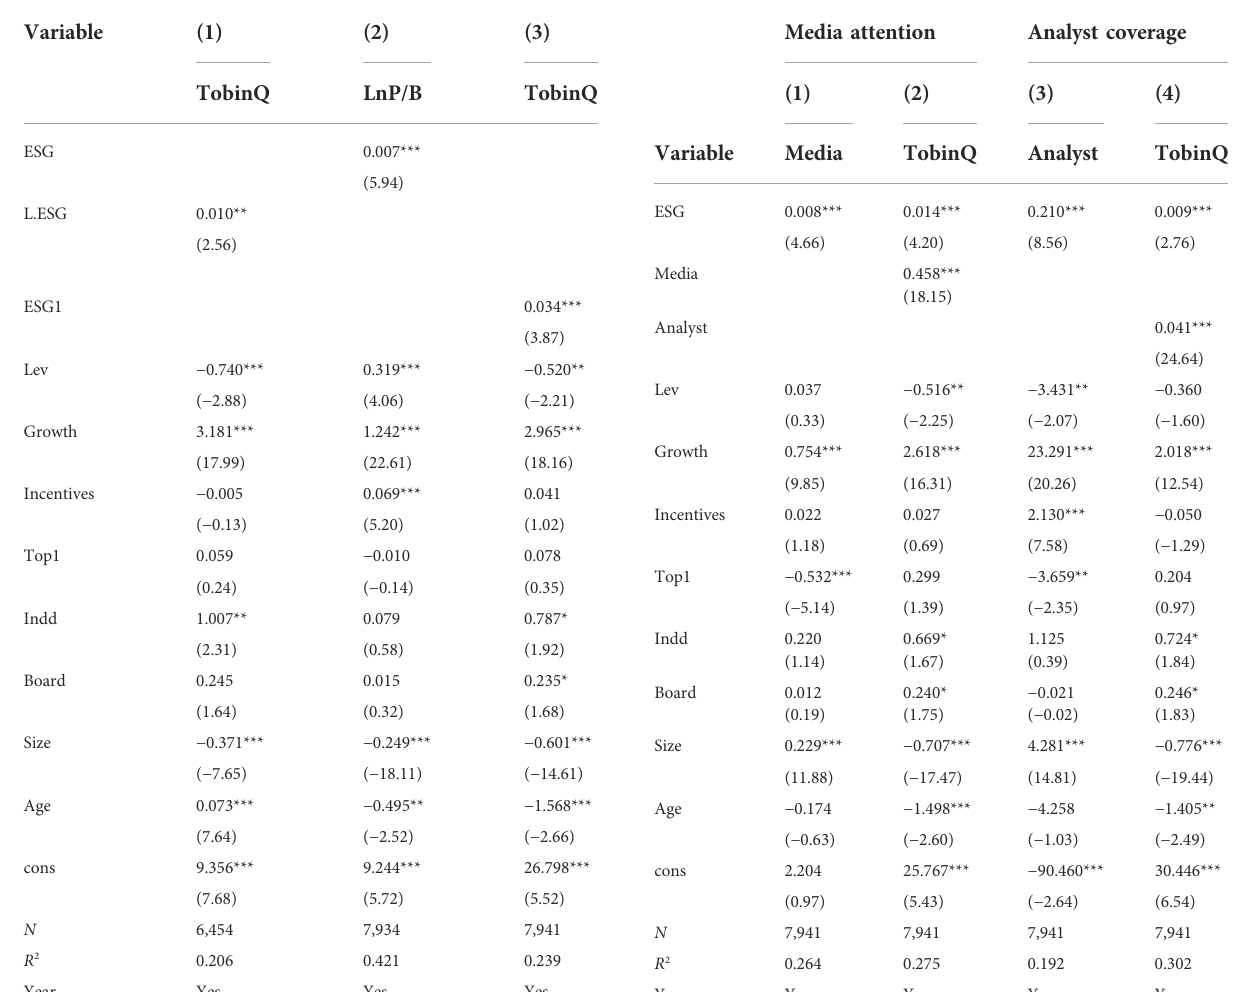
TABLE 5 Robustness tests. TABLE 6 Mediating effect of media attention and analyst